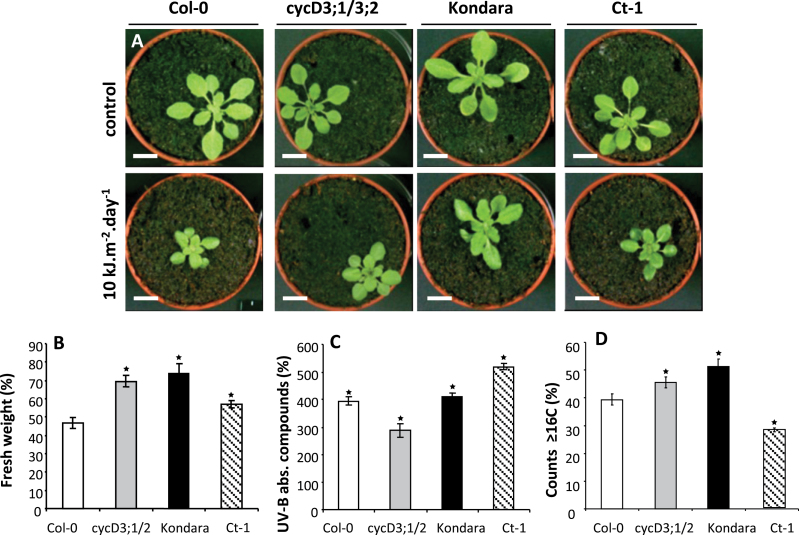
High endopolyploidy levels confer differential response to solar UV-B radiation in natural Arabidopsis accessions. (A) Rosettes of 30-d-old plants grown with (top) or without (bottom) supplementary UV-B radiation (10 kJ m–2 d–1). Bars, 1cm. (B) Fresh weight of whole rosettes after 16 d of exposure to UV-B (10 kJ m–2 d–1). (C) UV-B absorbing compounds induced after 16 d of exposure to UV-B. Values in B and C are mean percentages ± standard deviation of the mock plants. (D) Mean percentages ± standard deviation of the endopolyploidy fractions that corresponded to 16C and above (≥16C). Asterisks indicate significant differences with Col-0 (P < 0.01 after pairwise comparison (2-tailed t-test); for two-way ANOVA comparisons see Supplementary Table S6 available at JXB online).